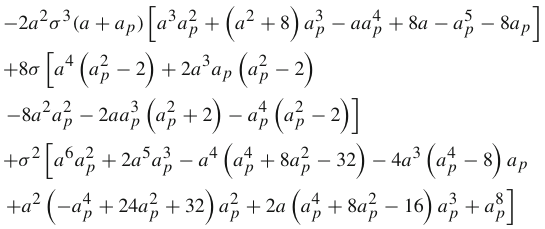
Fig. 32 Differences for the second frequencies ω (cid:27) ( a , r ± ( a p )) − ω ± spins a / M = 5 / 3 and a = M are also shown. Solutions of ω (cid:27) ( a , r ± ( a p )) = ω ± − 2 a 2 σ 3 ( a + a p )